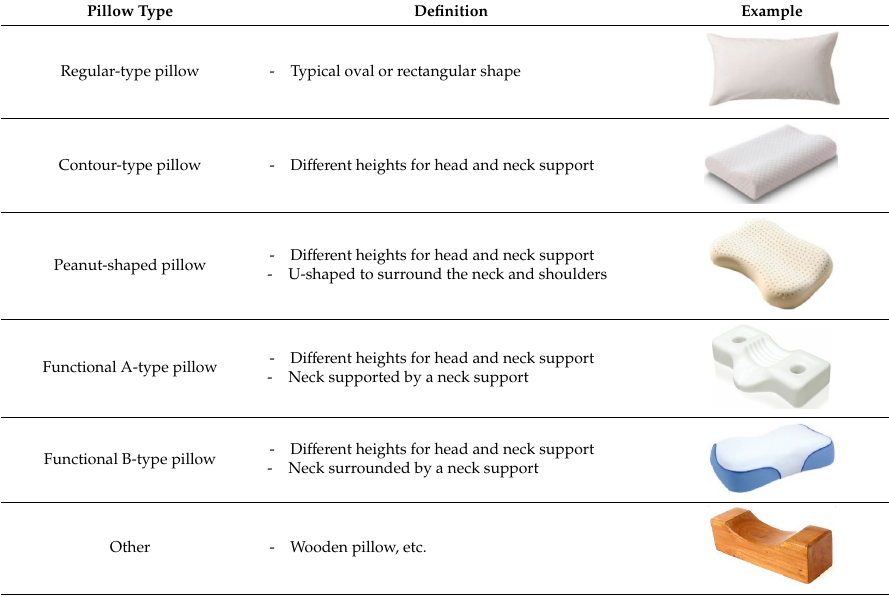
Table 3. T-test and ANOVA results for sleep habits (Mean